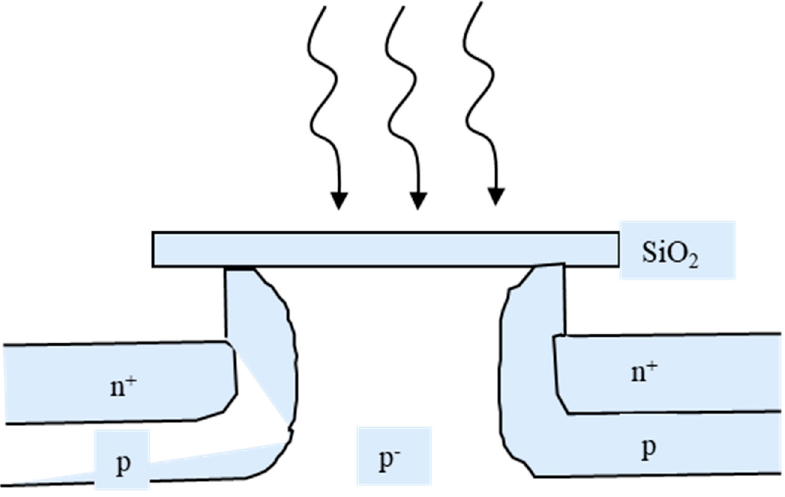
Figure 45. Schematic device structure of Si N+-pp-p-N+ avalanche